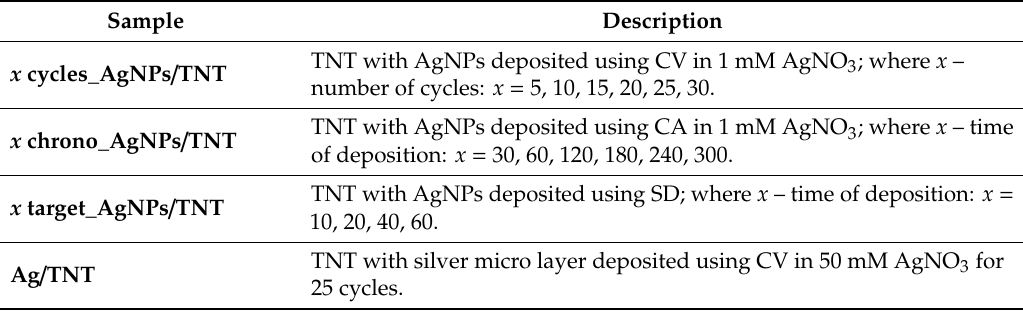
Table 1. Summary of the naming of the performed